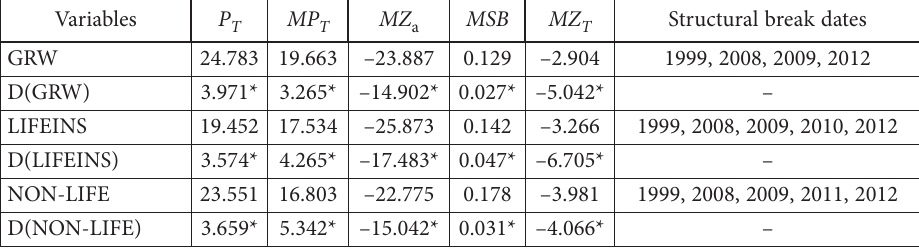
Table 5. Panel unit root test with multiple structural breaks (source: own processing)